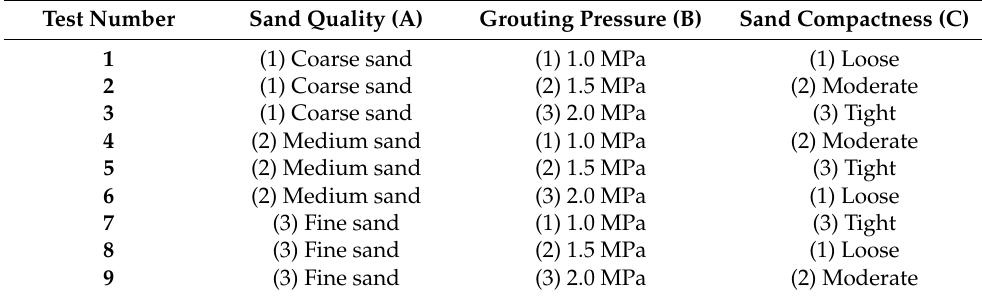
Figure 5. Chemical grouted sands destruction form: ( a ) EP grouted sands; ( b ) acrylate grouted sands.